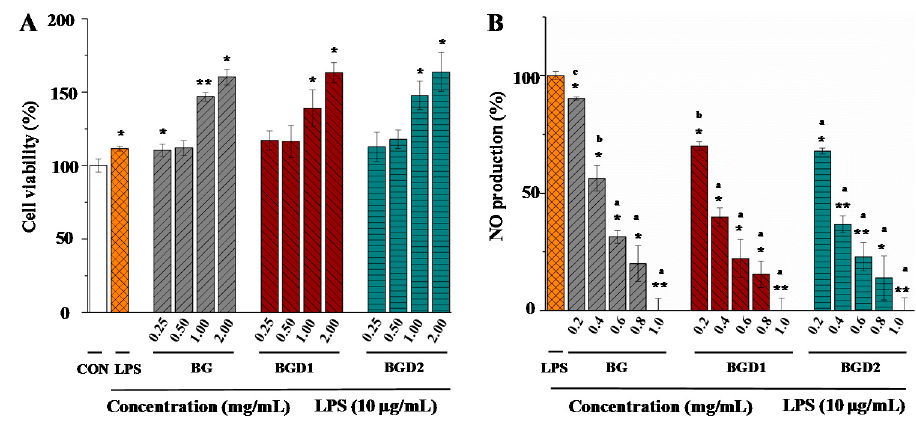
Figure 4. Cell viability ( A ) and NO production ( B ) of RAW264.7 macrophages treated with Qingke β -glucans. BG , Qingke β -glucan; BGD1 , Qingke β -glucan with acid hydrolysis for 10 min; BGD2 , Qingke β -glucan with acid hydrolysis for 20 min; The error bars are standard deviations; the differences of cell viability between sample and control are significant at * p < 0.05, ** p < 0.01; the differences of NO production between sample and LPS control group are significant at * p < 0.05, ** p < 0.01; significant ( p < 0.05) differences of NO production among BG, BGD1 and BGD2 are shown by data bearing different letters (a–c).